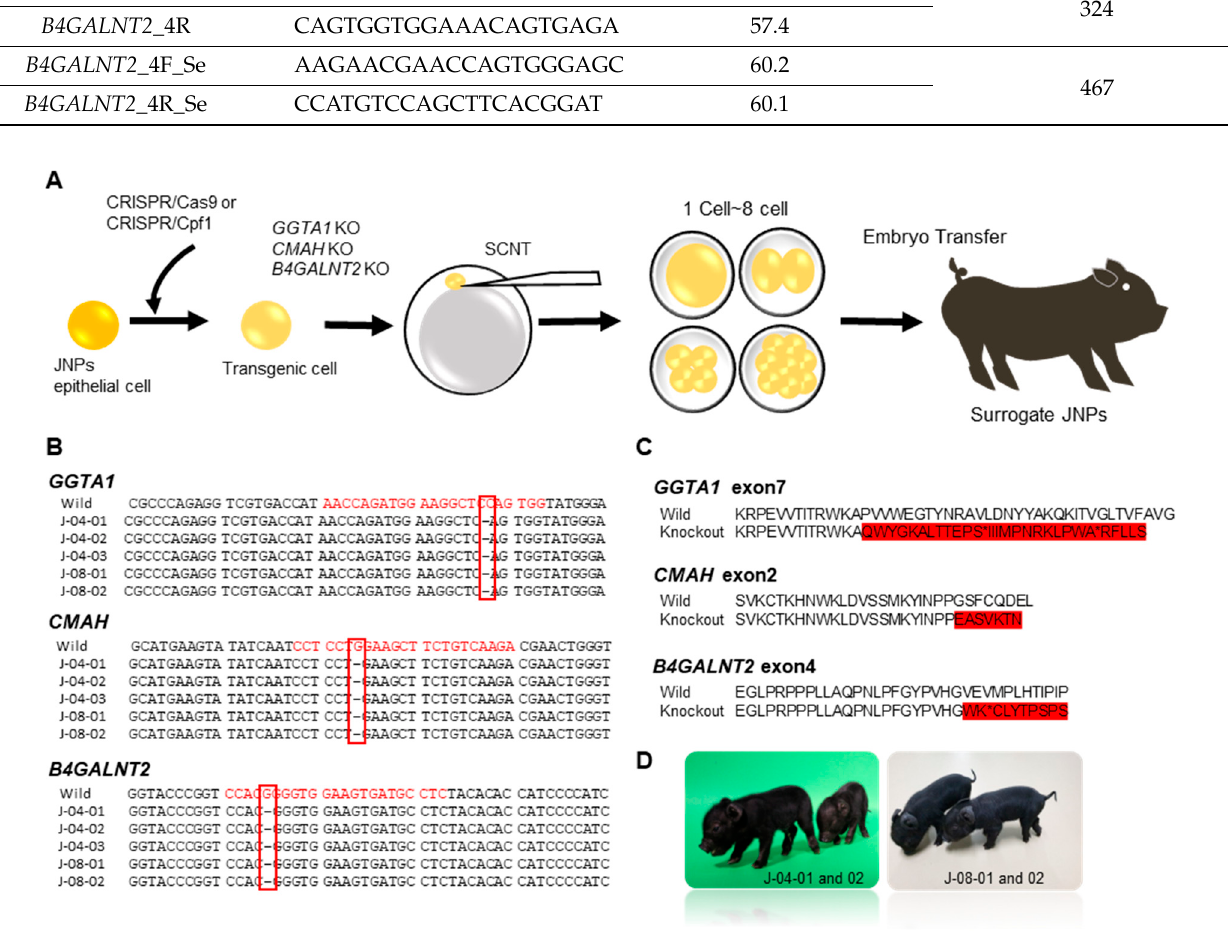
Figure 1. Schematic workflow of the generation of triple-knockout Jeju Native Pigs (JNPs), including gene editing strategies and steps required to obtain the modified JNPs. ( A ) Schematic diagram for triple-knockout development; ( B ) the sequences of GGTA1 , CMAH , and B4GALNT2 ; ( C ) deep sequence analysis of the target region of genes in delivered piglets and details of the target sequences in exon 7 ( GGTA1 ), exon 2 ( CMAH ), and exon 4 ( B4GALNT2 ); ( D ) knockout piglets produced. SCNT, somatic cell nuclear transfer. ( B ) Red color nucleotide sequences: sgRNA and PAM sequences; ( B ) Red box indicate deleted nucleotide base sequence by RNP complex; ( C ) red highlighted sequences indicate mutated amino acid. Table 3. Production of triple-knockout